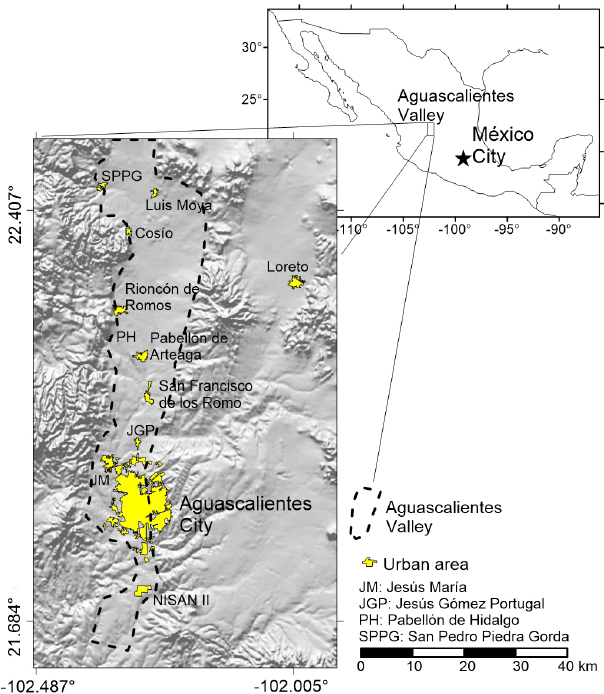
Figure 1. Location of Aguascalientes Valley in the context of Mex- ico, and location of the main settlements into the valley. Modified from Pacheco-Martínez et al.